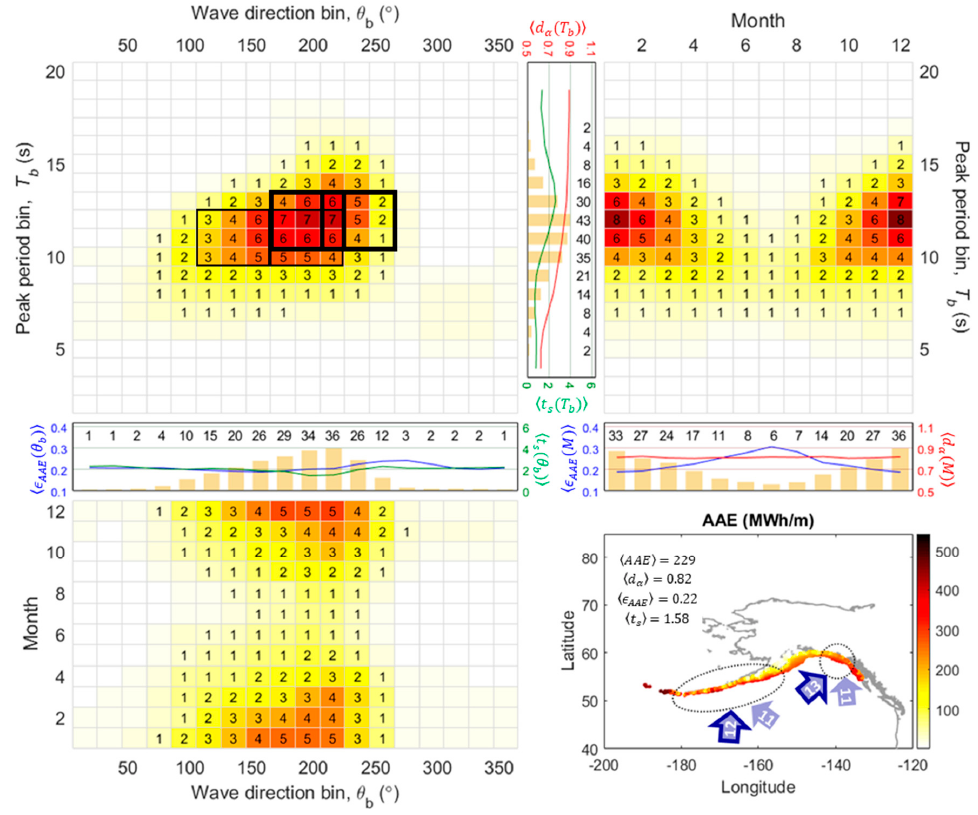
Figure 3. [Region 2: Aleutian Trench and Gulf of Alaska] The detailed descriptions are identical to Figure 2.